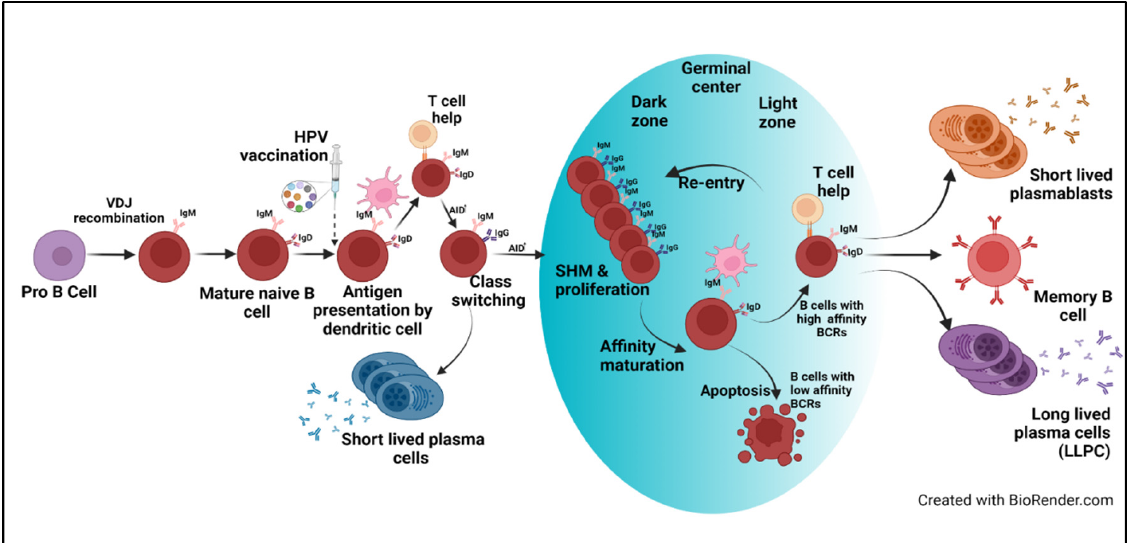
Figure 1. B cell activation, maturation, and proliferation upon exposure to antigens included in the HPV. Dendritic cells present HPV antigens included in the vaccine to naïve B cells. Binding to HPV antigens by B cell receptors results in B-cell activation and proliferation. Some B cells rapidly differentiate into plasma cells that secrete antibodies. B cells that receive additional signals from CD4 + T-follicular helper cells (TfH) express AID which is required for antibody class switching and somatic hypermutation (SHM) of antibody gene sequences. Germinal centers develop, containing activated B cells, activated TfH and dendric cells. It is in the light region of the germinal center that B cells compete for interaction with TfH, B cells with higher affinity receptors bind antigen and present peptides to TfH which in turn provide survival signals that promote further proliferation and continued SHM which takes place in the dark zone. B cells with low affinity receptors that do not receive survival signals undergo apoptosis. B cells can go through repeated rounds of SHM resulting in affinity maturation of the antibody genes, until cells exit as either short-lived plasmablasts, long-lived plasma cells, or memory B cells [Created with BioRender.com (Accessed from January to April 2022)].